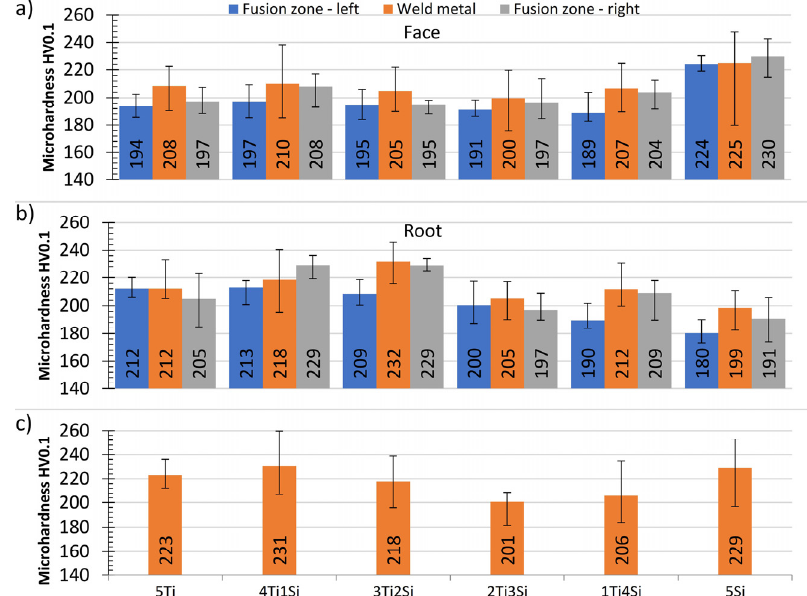
Figure 11. Average microhardness results for weld face horizontal measurements ( a ); weld root horizontal measurements ( b ); weld metal vertical measurements ( c ).